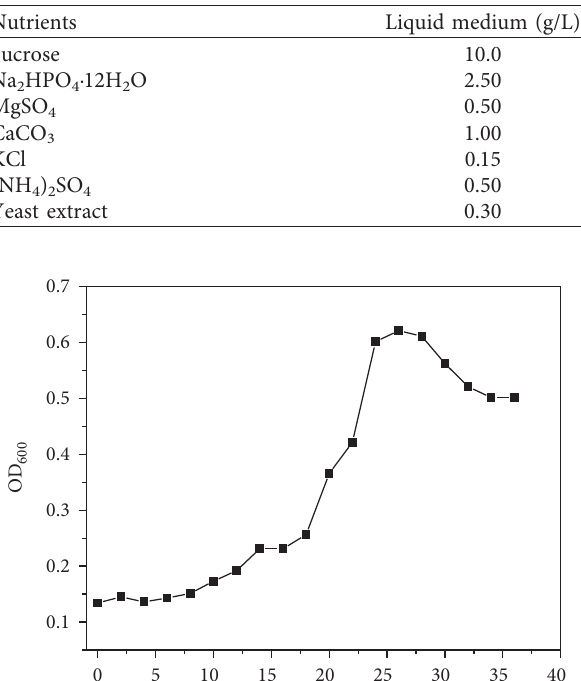
Table 2: Paenibacillus